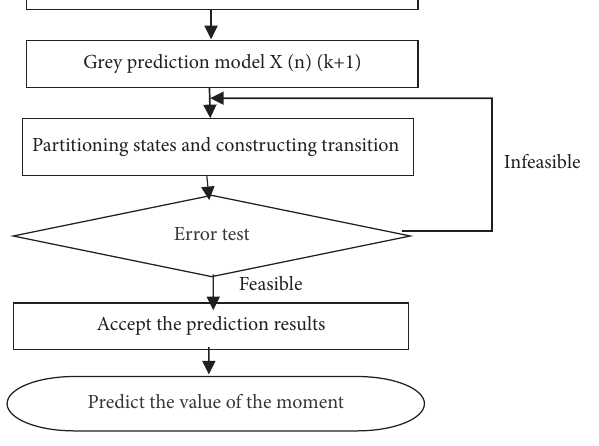
Figure 2: Grey Markov model process.